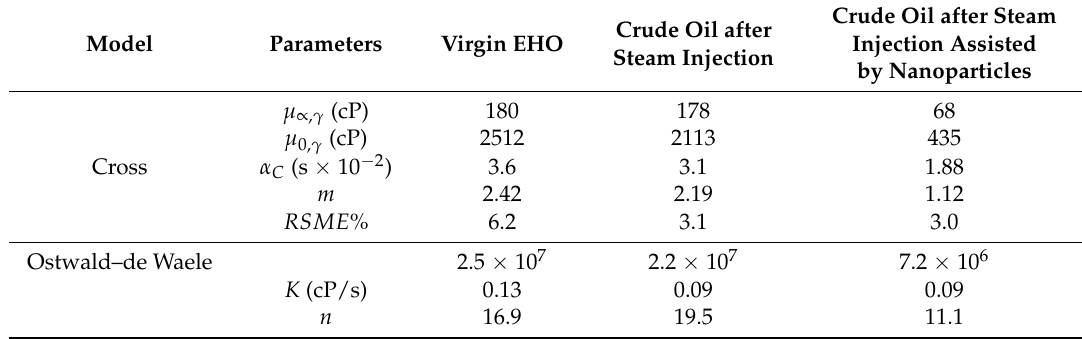
Table 2. Rheological parameters of the Cross and Ostwald–de Waele models for virgin extra heavy crude oils (EHO), crude oil after steam injection and crude oil after steam injection assisted by SiNi1Pd1 nanoparticles at 25 ◦ C. Crude Oil after Steam Crude Oil after Injection Assisted Model Parameters Virgin EHO Steam Injection by Nanoparticles µ ∝ , γ (cP) 180 Cross